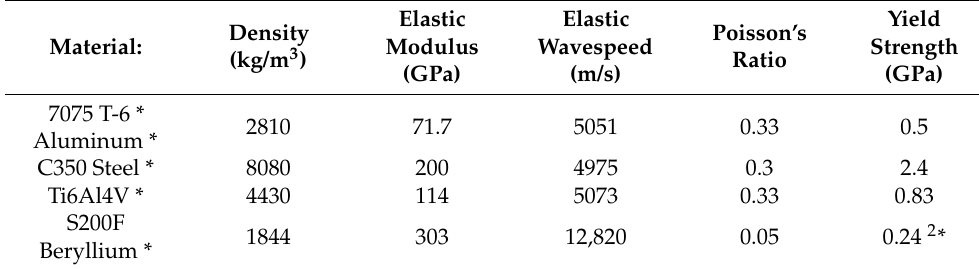
Table 1. A few pertinent physical properties of commercial purity beryllium, 7075-T6 aluminum, C350 maraging steel, and